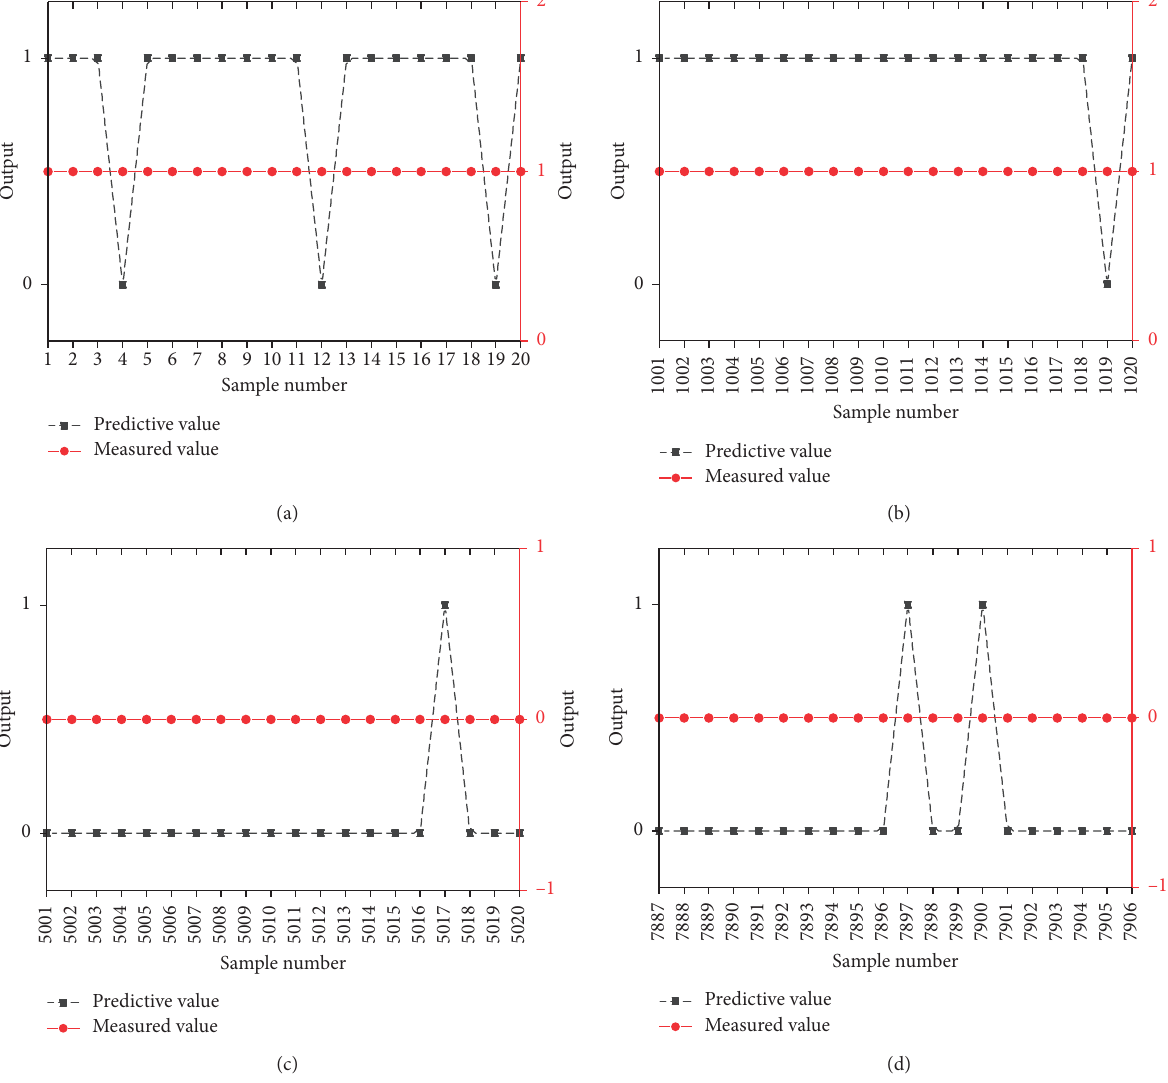
Figure 4: Comparison chart of the predicted and actual values of the BP neural network (a part of the sample): (a) number: 1–20, (b) number: 1001–1020, (c) number: 5001–5020, and (d) number: 7887–7906. Due to the large sample size, only a part of the sample comparison chart is